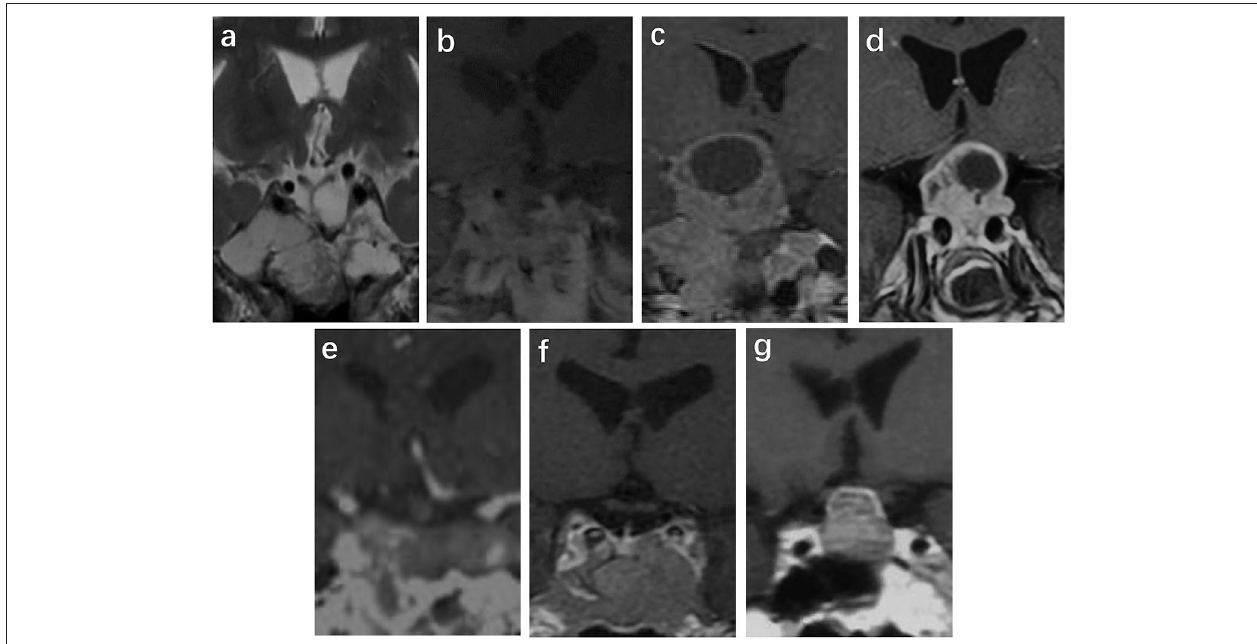
FIGURE 1 | Images at the time of diagnosis of a functional SCA in cases 1–7 (a–g) . Sella MRI was performed in cases 1 (a) , 2 (b) , 3 (c) , 4 (d) , 6 (f) , and 7 (g) . Sella CT was performed in case 5 (e) because a pacemaker was installed. There is cavernous invasion in (b) , sphenoid sinus invasion in (d) , and both types of invasion in (a) . There are macrocystic changes and surrounding microcystic changes in (b,c) . According to T2-phase MRI of case 1 (a), the tumor tended to have cystic